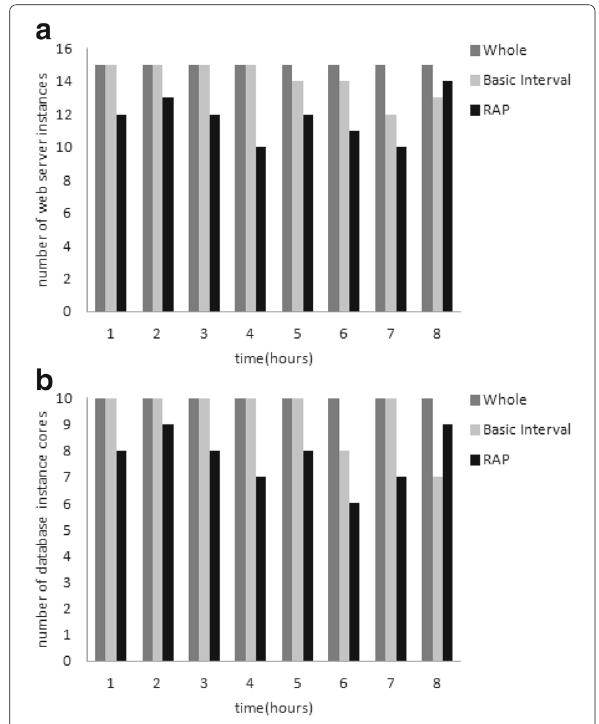
Fig. 8 RAP vs. Burstiness agnostic approaches. a Web server instances. b Database instance